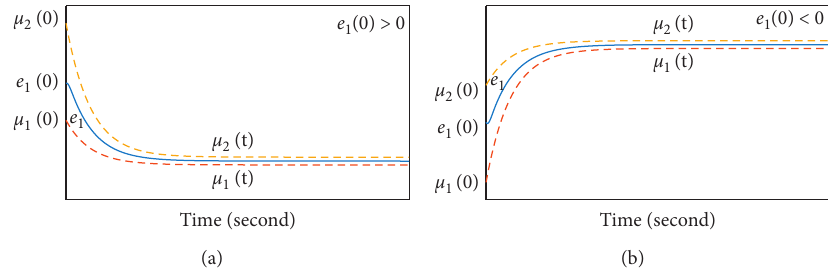
Figure 1: Graphical illustration of prescribed performance function (11) with (a) e